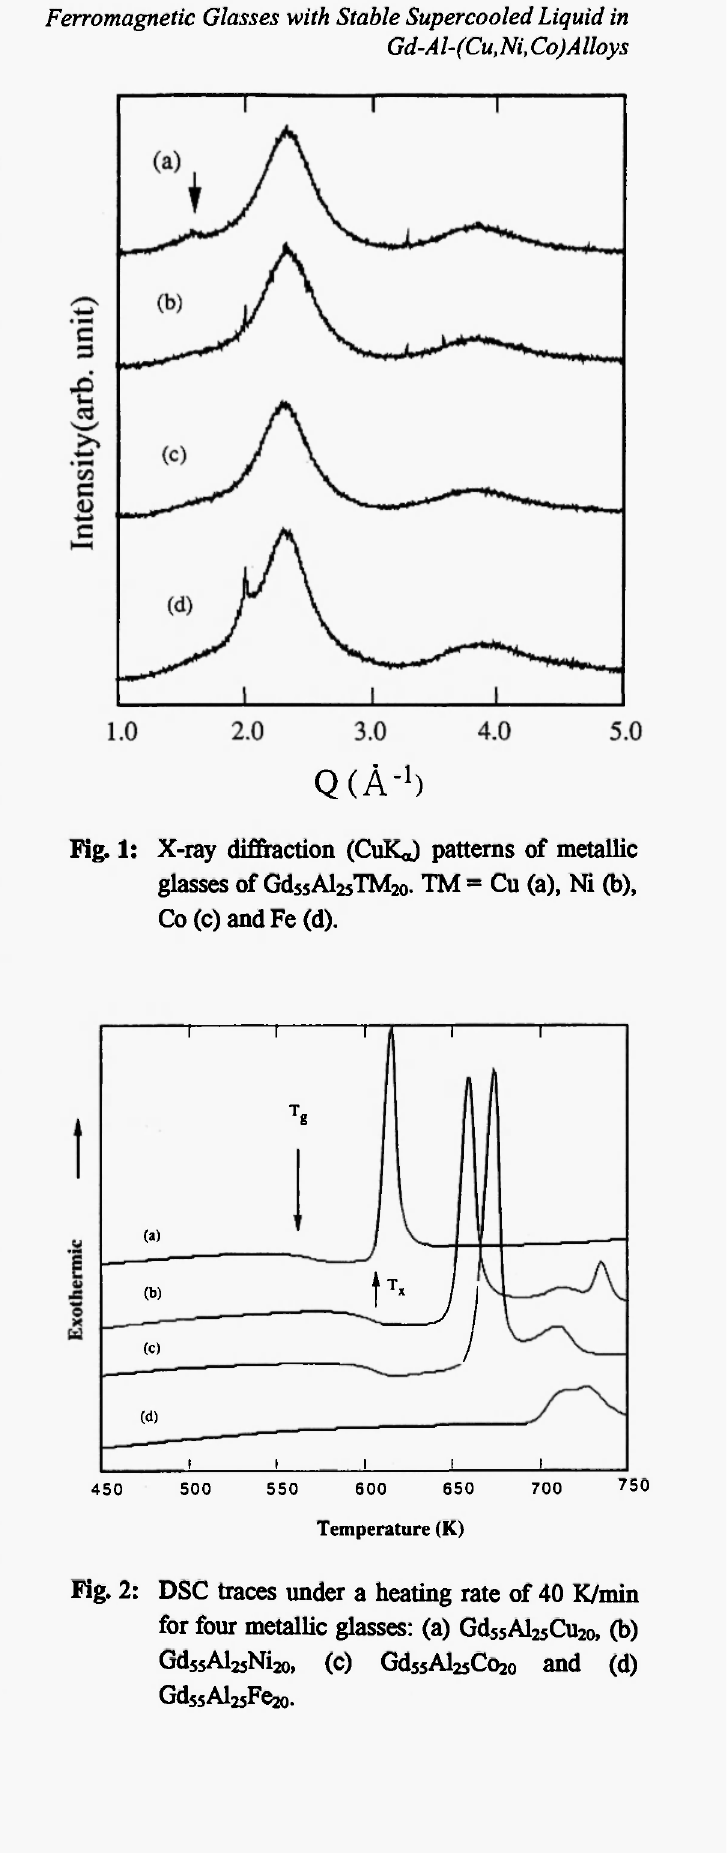
Cu , (b) 20 5 5Al 25